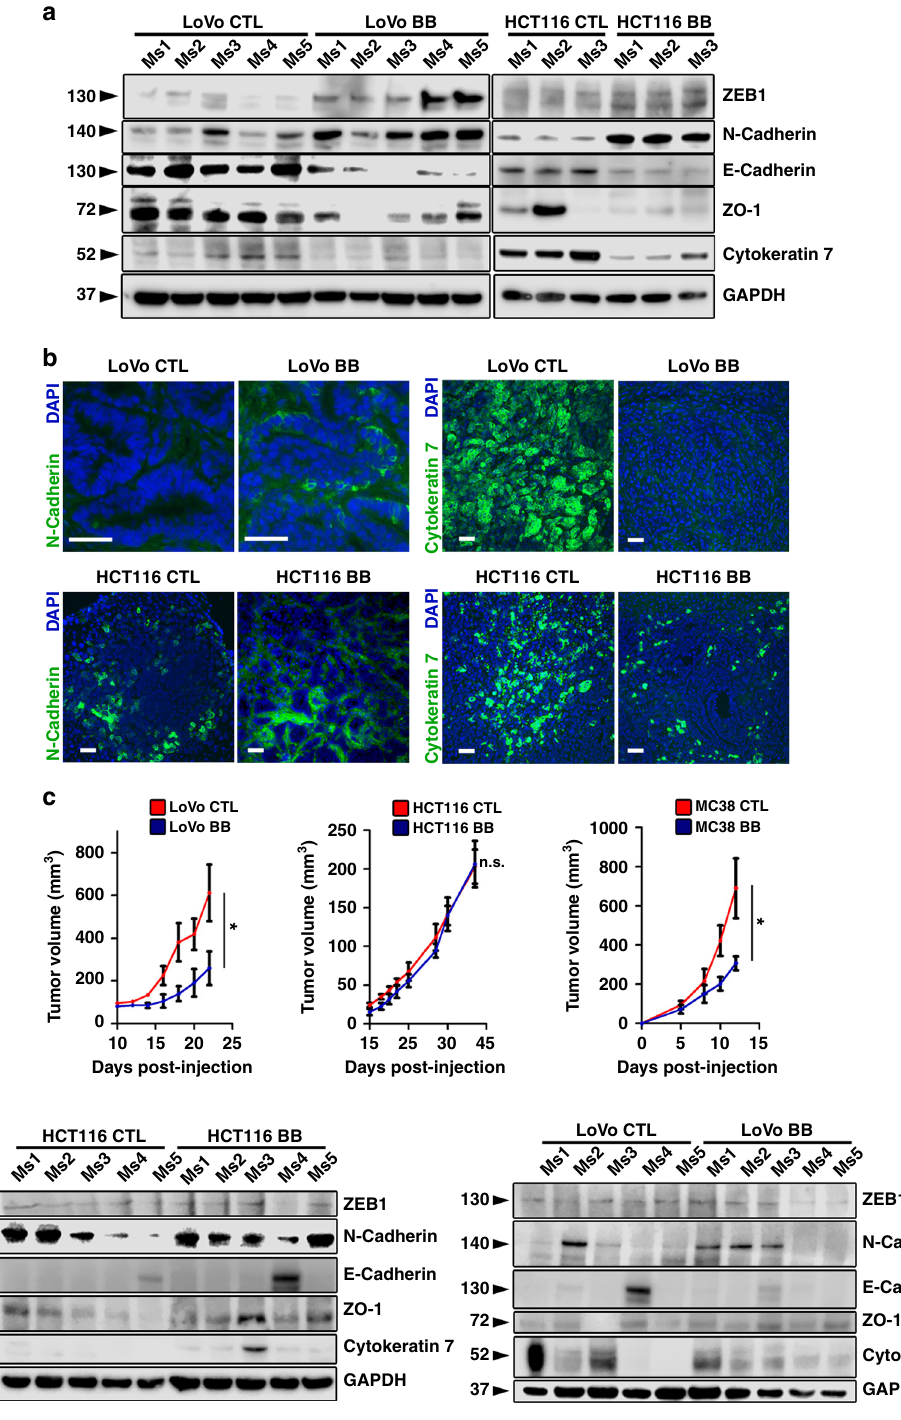
Fig. 6 Pharmacological inhibition of PADs alters EMT markers in experimental hepatic metastases but not in subcutaneous xenografts. a Immunoblotting for the indicated EMT proteins performed on tissue lysates from the experiment in Fig. 5f. GAPDH was used as a loading control. b Representative images of staining for indicated proteins in experimental hepatic metastases from Fig. 5f. At least fi ve biological replicates were stained per group. Scale bar = 100 μ m. c Subcutaneous tumor growth curves of mice injected with indicated cells and treated with vehicle ( n = 5, 5, and 6 biological replicates) or BB-Cl- amidine ( n = 5, 5, and 5 biological replicates). Repeated twice. d Immunoblotting for the EMT marker proteins as indicated performed on tissue lysates from ( c ). For c , error bars indicate s.e.m. (* P < 0.05, n.s. = non-signi fi cant, two-way ANOVA). Ms – mouse. CTL control, BB